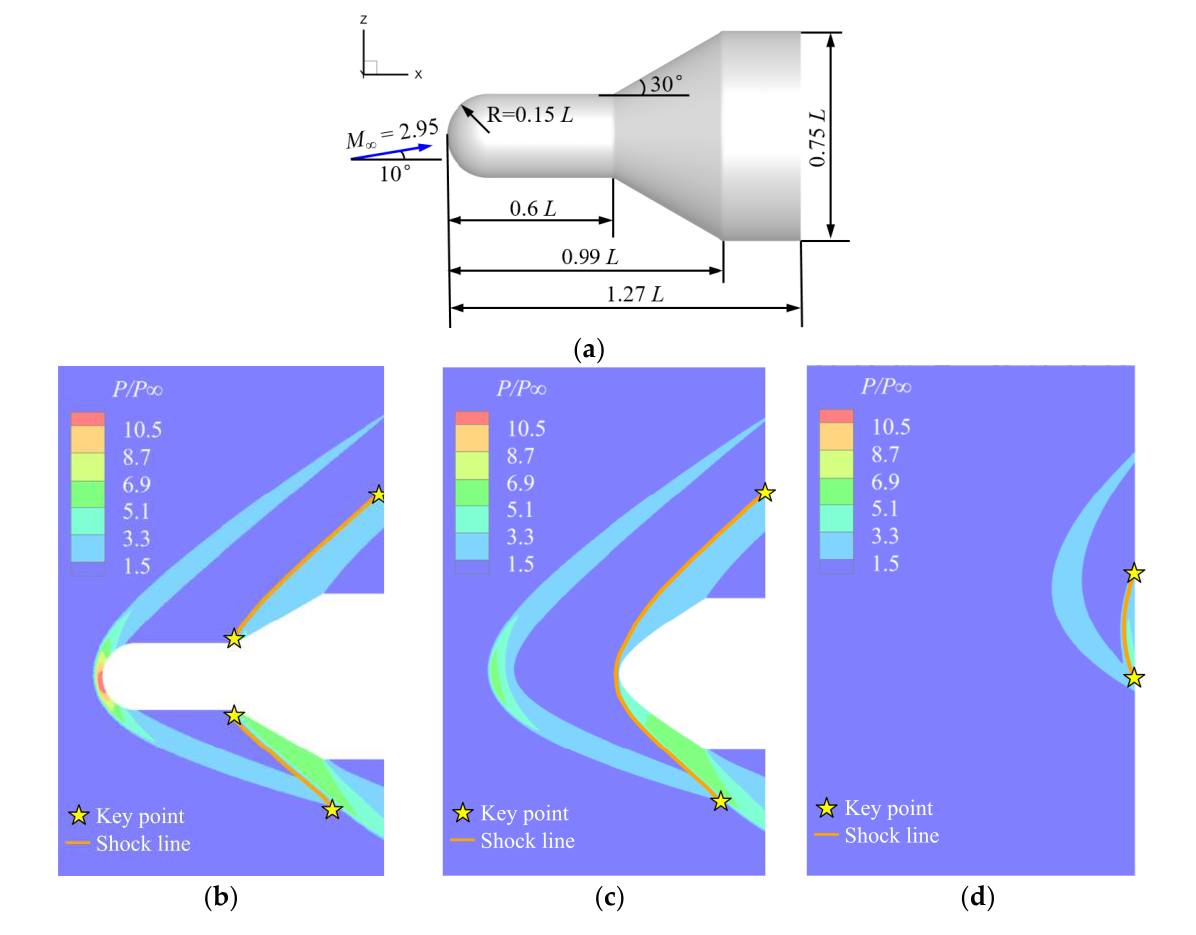
Figure 12. Interaction between curved shock surfaces: ( a ) numerical calculation domain. Shock lines from embedded shock at various semitransparent slices with ( b ) y = 0 (the vertical symmetric plane), ( c ) y = 0.15 L , and ( d ) y = 0.72 L .